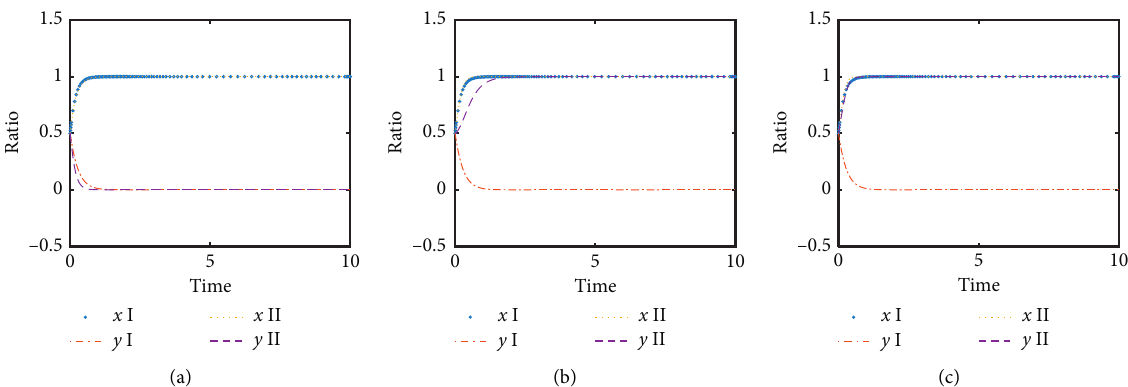
Figure 8: The influences of the cost coefficient of knowledge sharing on the evolution system. (a) C (c) C g � 0 . 1 ,C s � 0 . 2.